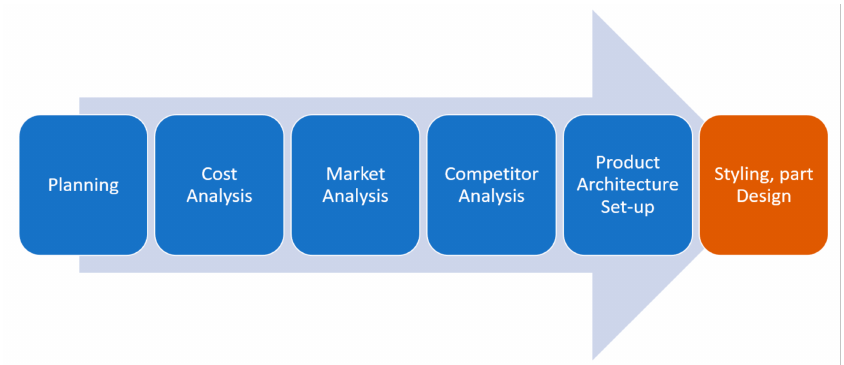
Figure 2. IDeS product set-up